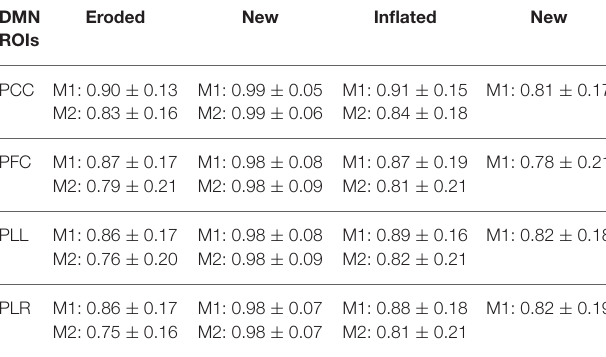
TABLE 4 | Average correlation of time-series extracted from each region of the DMN using different masks with the original time-series. DMN